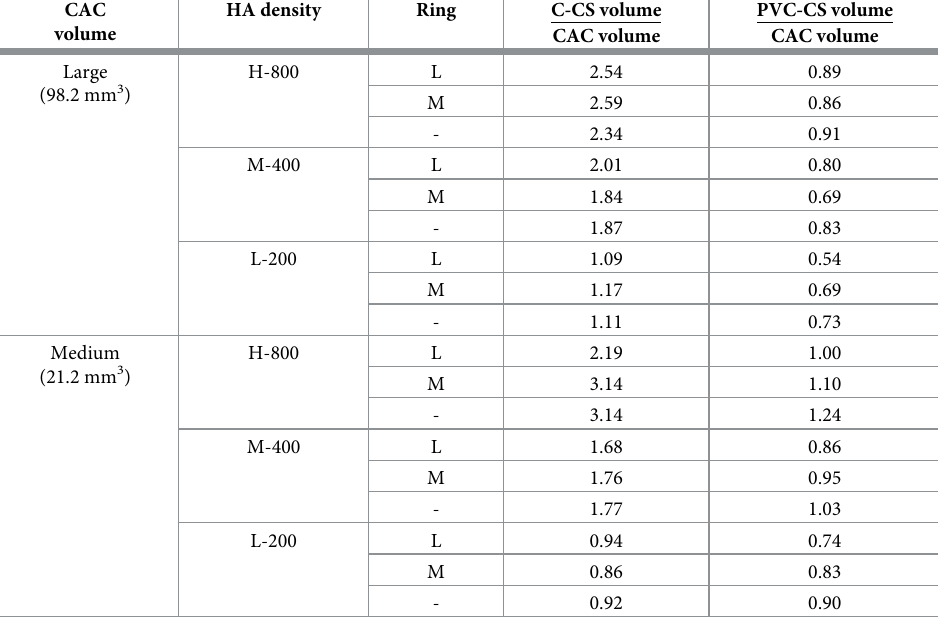
Table 3. Ratios between reference CAC volumes and calculated CAC volumes determined using C-CS and PVC-CS performed on the CEORA phantom. Results are grouped per lesion size (Large and Medium) and HA den- sity (H-800, M-400, L-200 mg/cm 3 ) of each calcium insert and listed per ring configuration (No ring (-), M, L). Pre- sented values are averaged over five different acquisitions.